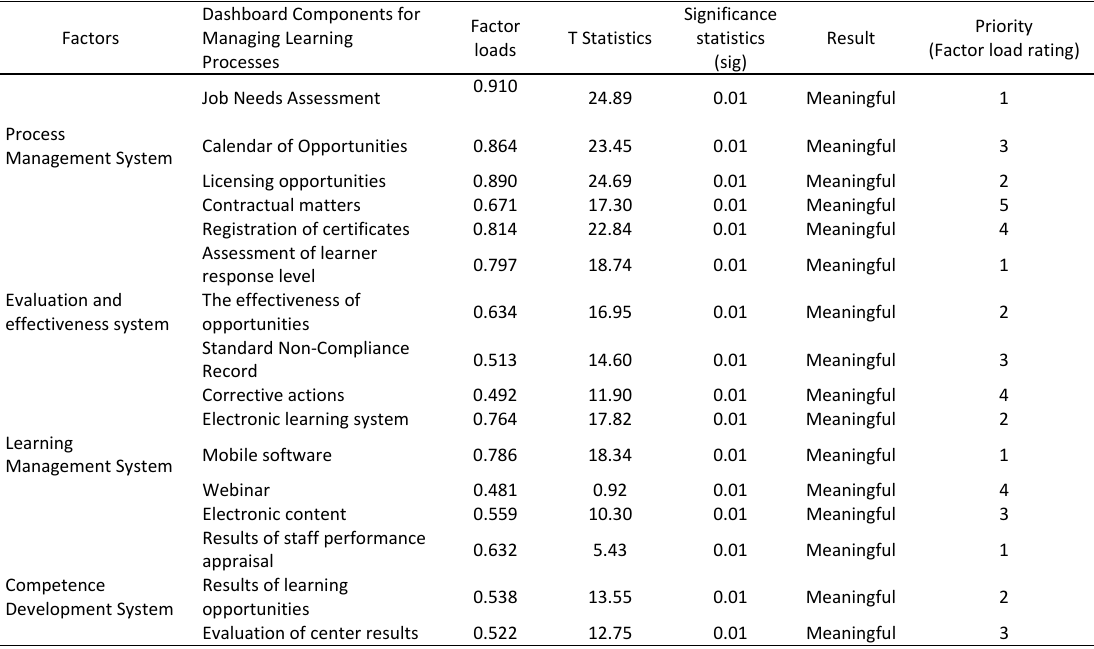
Table 2: Results of factor loads Table 2. Results of factor loads